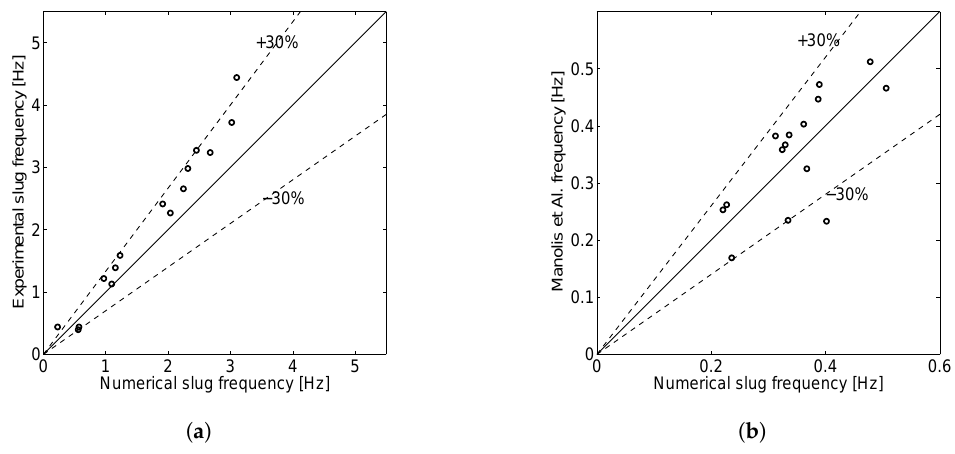
Figure 6. Slug mean frequency: several numerical results are bounded by the ± 30% confidence lines. ( a ) Pipe1: numerical results against experimental data; and ( b ) Pipe2: numerical results against empirical